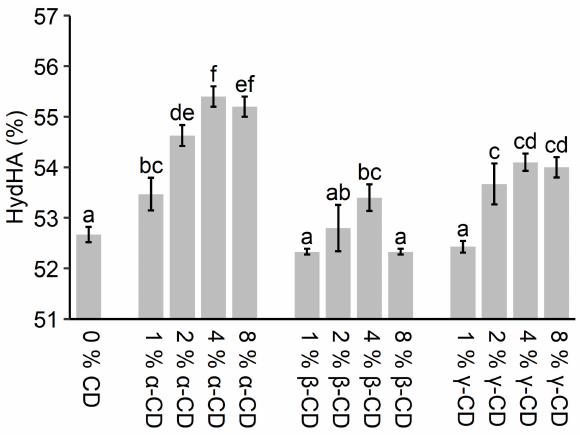
Figure 1. Water absorption for different types and concentrations of CD determined by the consisto- graph method. The water absorption is the hydration needed to obtain a dough with a maximum pressure of 2200 mbar. The error bars indicate the standard deviation. Different letters indicate the significant difference between the treatments ( p <